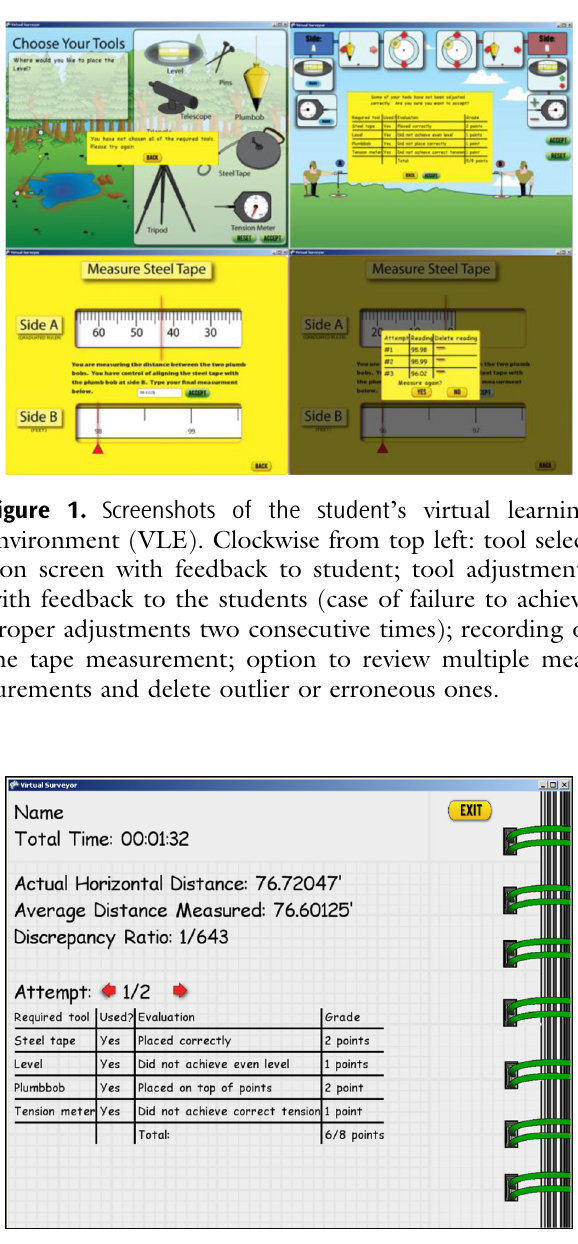
Figure 2. Example of summary report provided to the student at the end of the chaining exercise.